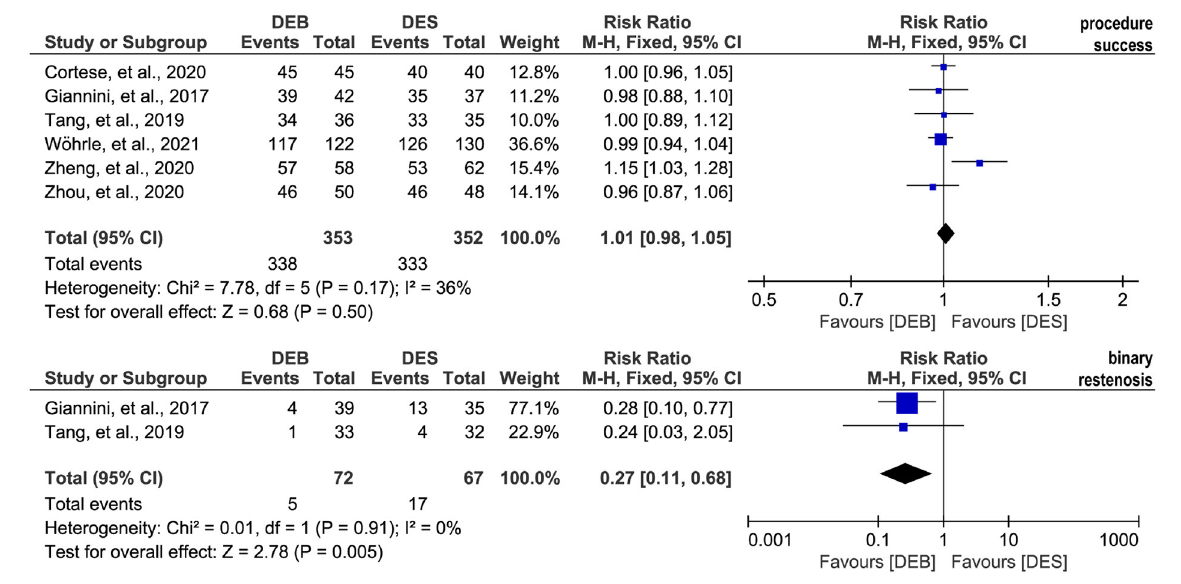
FIGURE4 Meta-analysis of the procedure success rate and binary restenosis. The black diamond represents the pooled result. If the black diamonds are completely to the left of the null line (“1”), it means that DEB is better than DES in terms of the procedure success and binary restenosis; if the black diamonds are completely to the right of the null line (“1”), it means that DEB is inferior to DES in terms of all outcomes; and if the black diamonds crossed through the null line (“1”), it means that DEB is comparable to DES in terms of all outcomes. DCB, drug-eluting balloon; DES, drug-eluting stent; M-H,